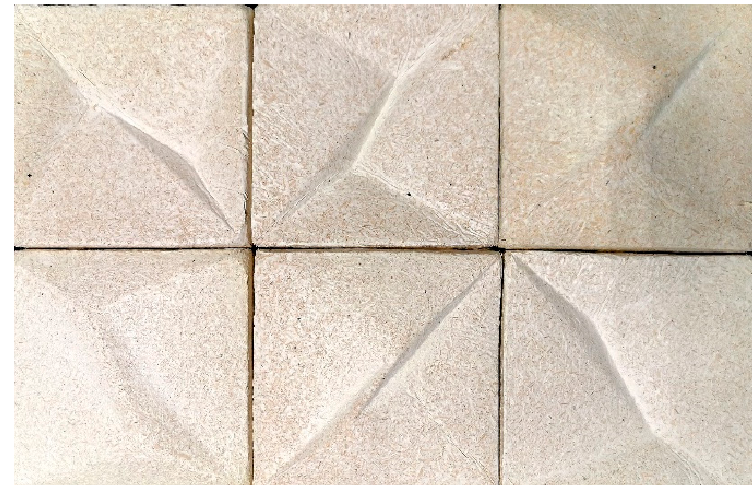
Figure 6. Arranging composition with the wall cladding panels formed in chamotte clay (photo by A.B.).